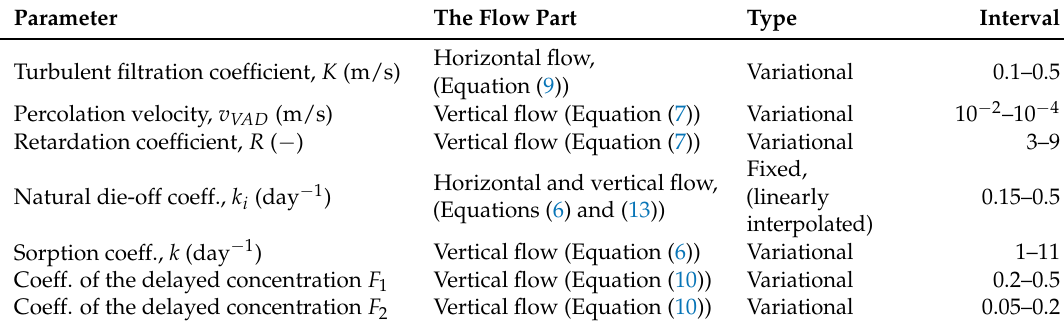
Table 4. The range of values of the variational and fixed parameters that appear in Equations (5)–(14). Parameter